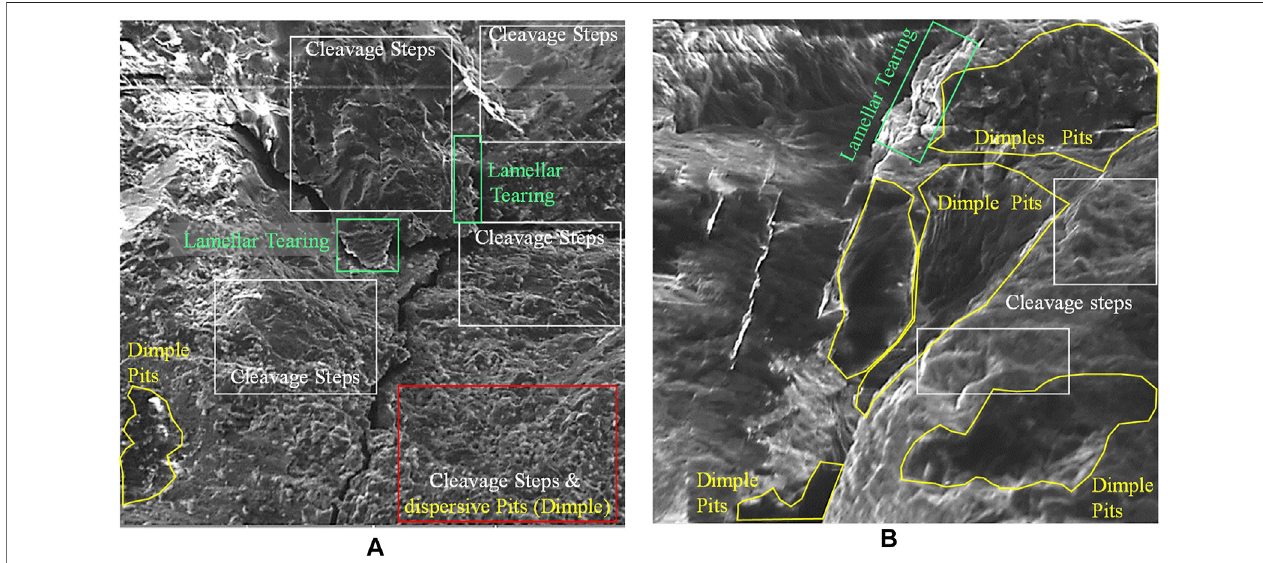
FIGURE 11 | Microstructure characteristics of cross sections of different CID coal samples: (A) CID (cid:2) 0; (B) CID (cid:2) 0.5221.